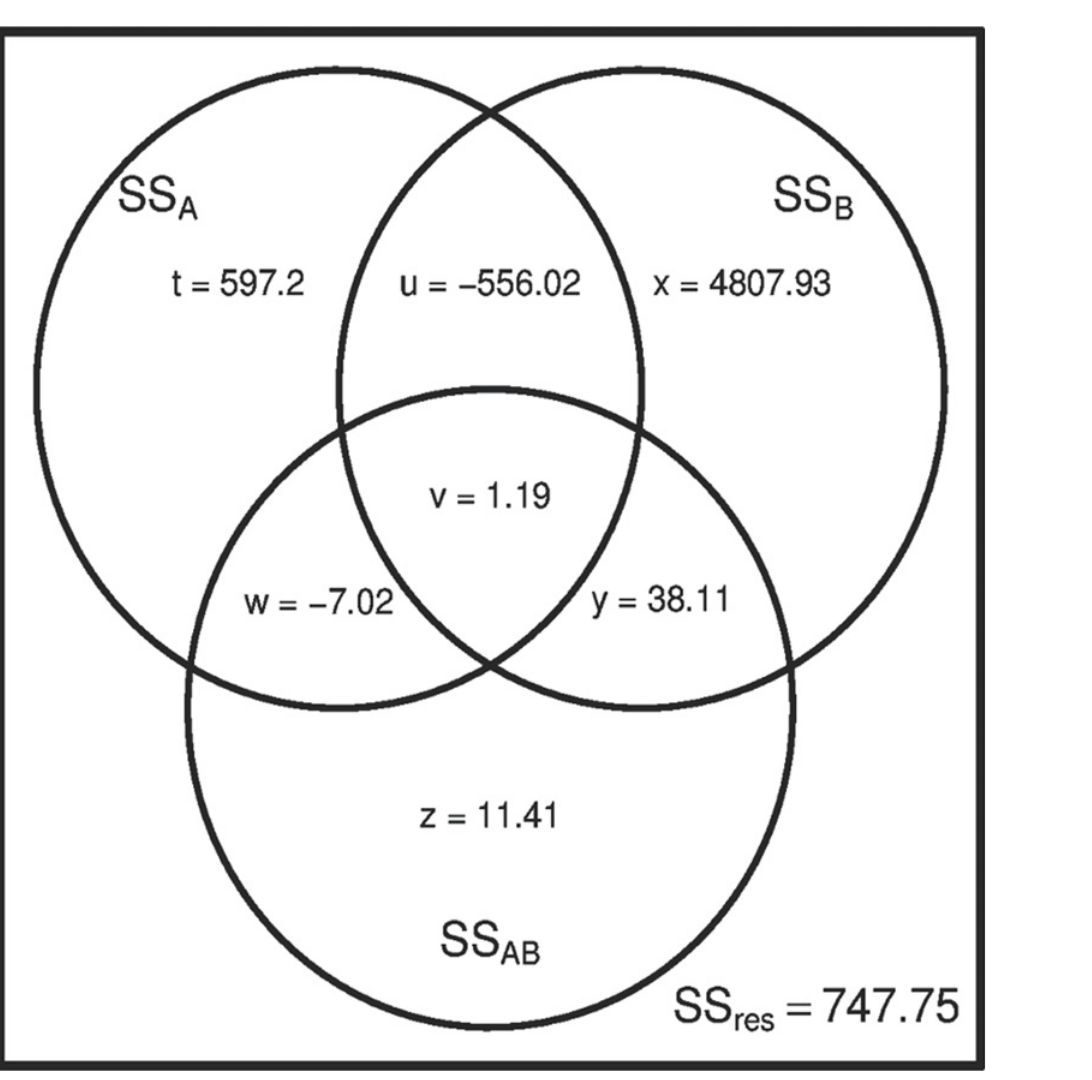
Fig 2. Venn diagram of the example data [13], using contrast coding (-1,